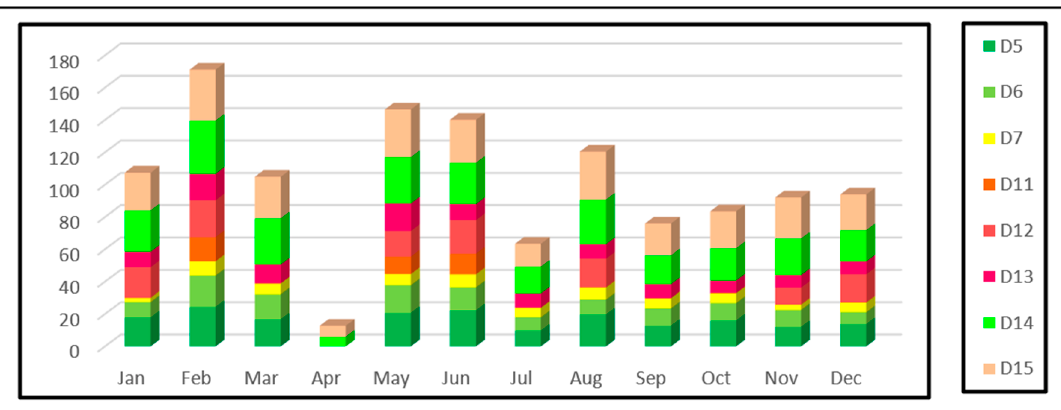
Table 14. Monthly unmet demands (MCM) resulting from decrease in the Ismailia Canal head flow by 10%.